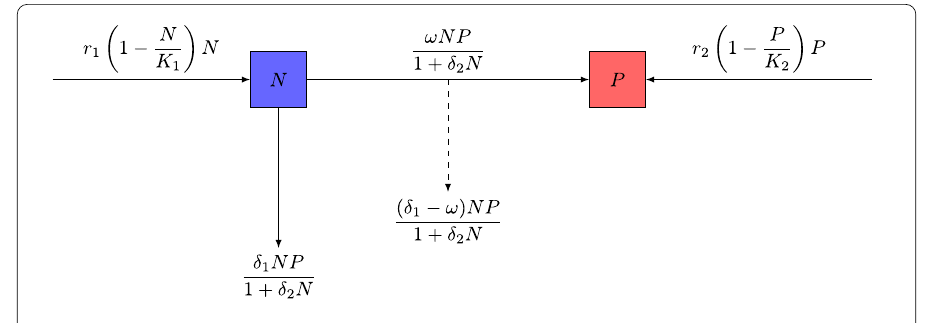
Figure 1 Interaction diagram for the prey-predator